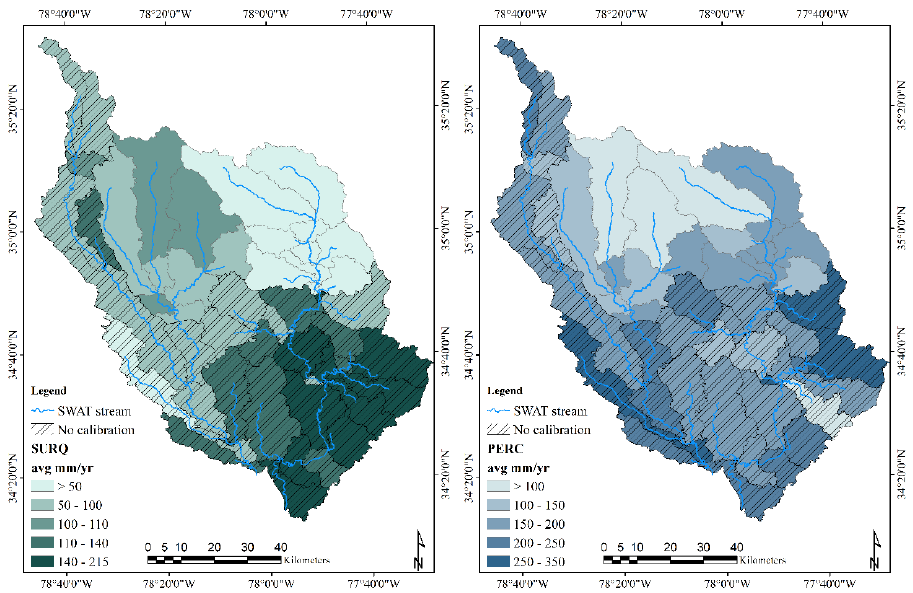
Figure 3. Yearly average estimates of surface runoff (SURQ) and percolation (PERC) from the validation period of 2010–2011 using SWAT-CUP.